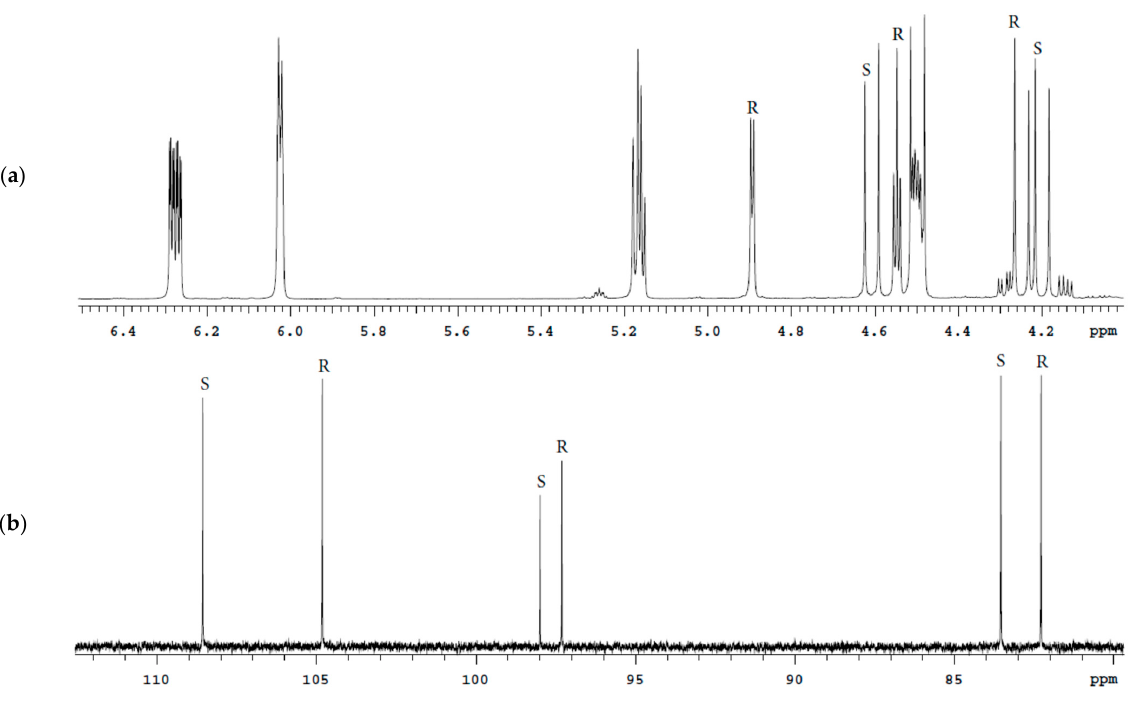
Figure 8. 1 H ( a ) and 13 C ( b ) spectra fragments of the Bud capsules solution in CDCl 3 with charac- Figure 8. teristic signals of 22 R and 22 S epimers.